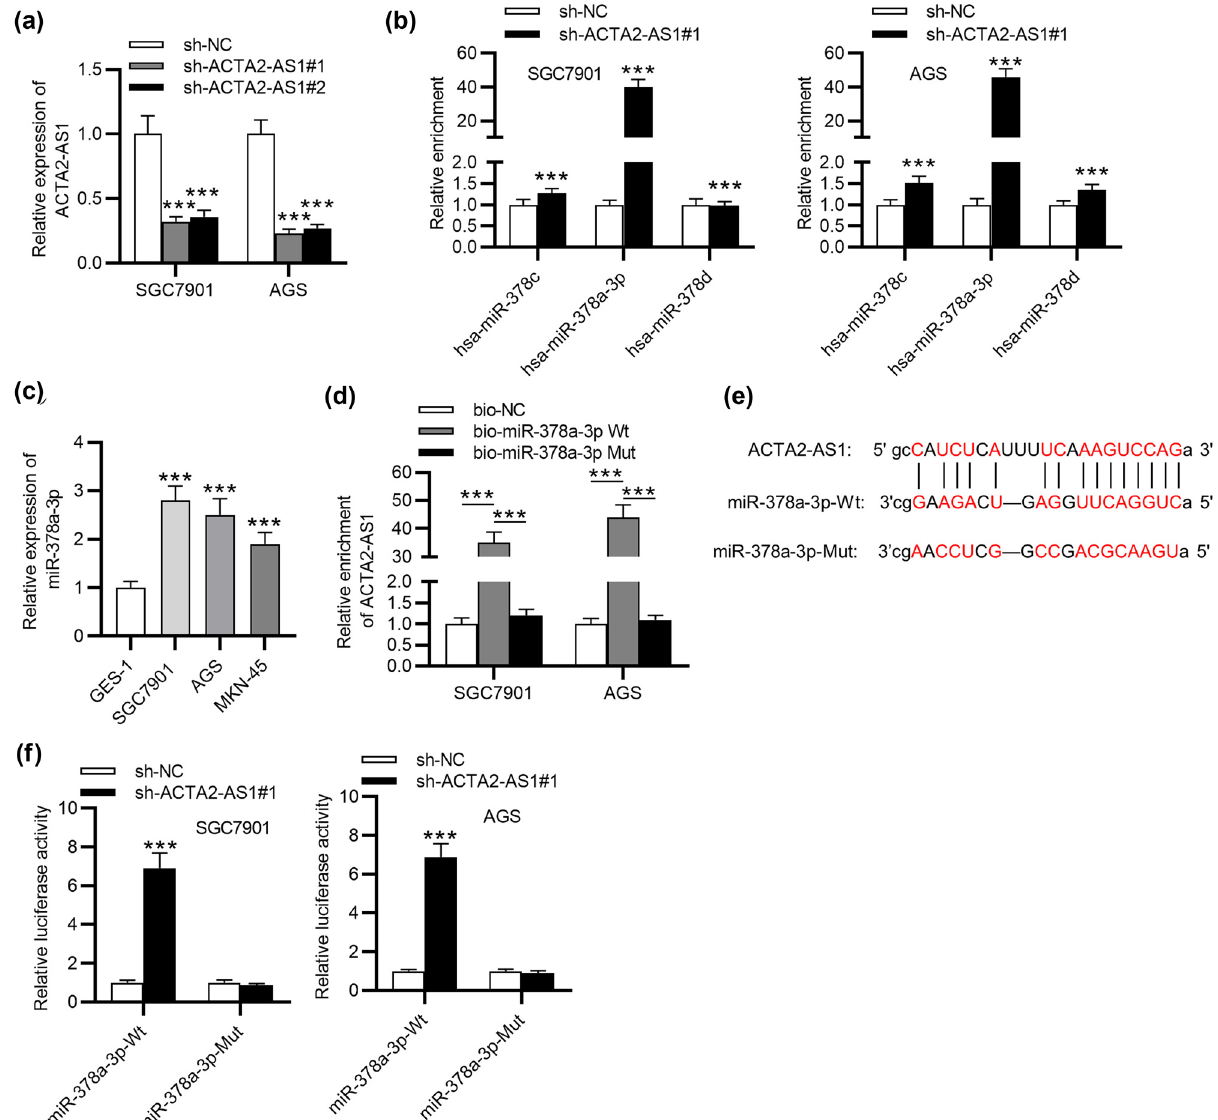
Figure 3: ACTA2 - AS1 interacts with miR - 378a - 3p in GC cells. ( a ) Knockdown e ffi ciency of sh - ACTA2 - AS1#1/2 was detected by RT - qPCR, and sh - ACTA2 - AS1#1 was used for the following experiments due to its better knockdown e ffi ciency. ( b ) RT - qPCR was utilized to examine the expression of candidate miRNAs in GC cells transfected with sh - ACTA2 - AS1#1 or sh - NC. ( c ) The expression of miR - 378a - 3p in GC cells and normal gastric epithelial cells was detected by RT - qPCR. ( d ) RNA pulldown assays were performed to determine the interaction between ACTA2 - AS1 and miR - 378a - 3p in cells. ( e ) The possible binding site between ACTA2 - AS1 and miR - 378a - 3p was predicted from the starBase website. ( f ) The binding capacity between ACTA2 - AS1 and miR - 378a - 3p was further tested by luciferase reporter assays. *** p <